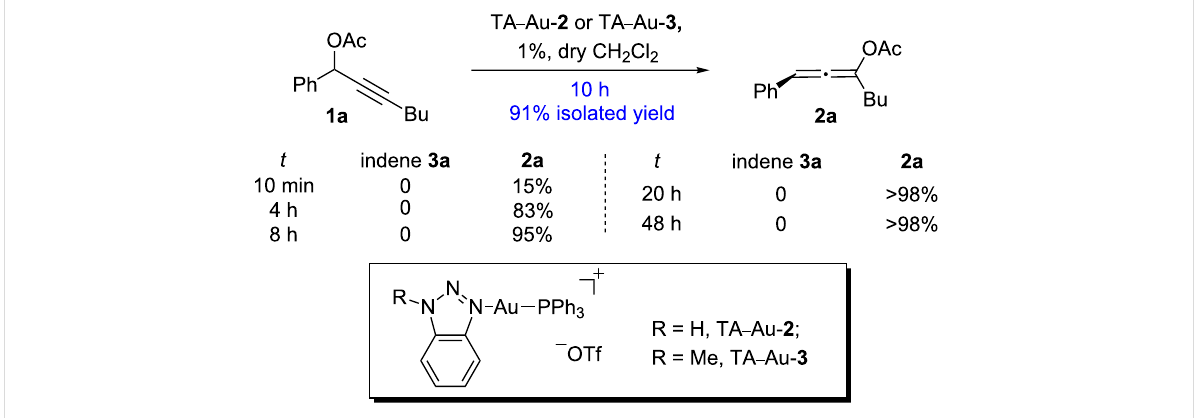
Figure 1: Chemoselective activation of alkyne over allene by the TA–Au catalysts.